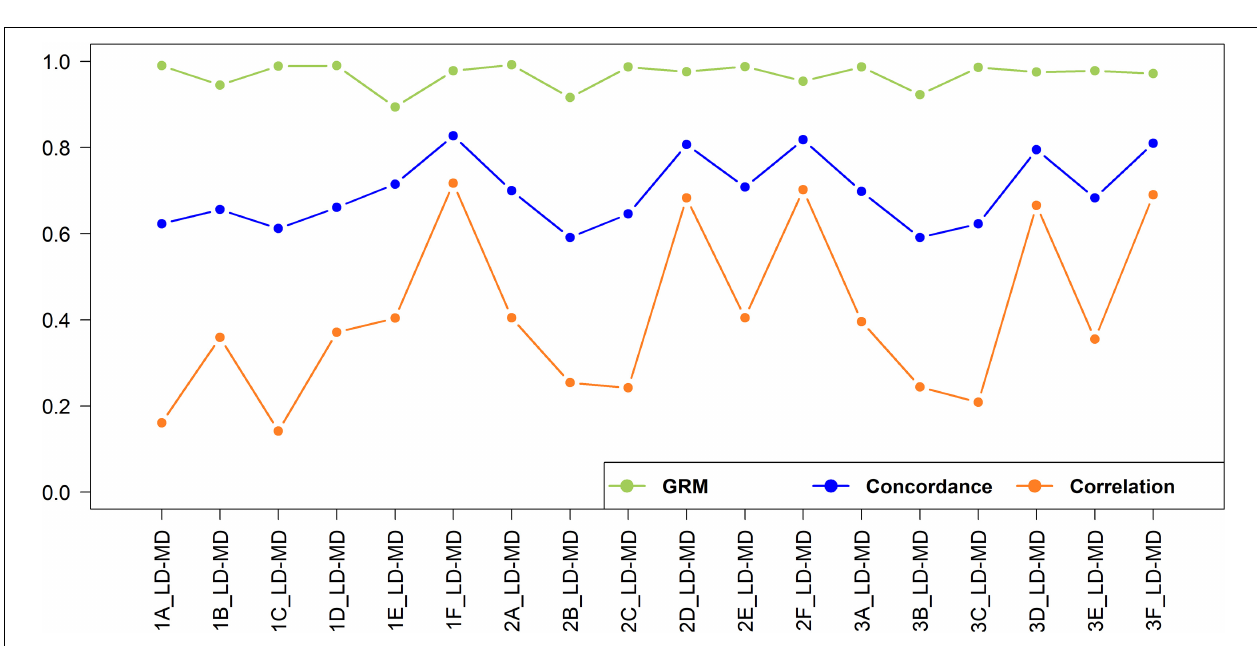
FIGURE 8 | Individual heterozygosity in West African crossbreds plotted against European breed proportion estimated from a three-way admixture using LAMP-LD. The black and green lines are upper and lower boundaries of expected heterozygosity for (A) Holstein-Friesian and (B) Montbéliarde crosses.